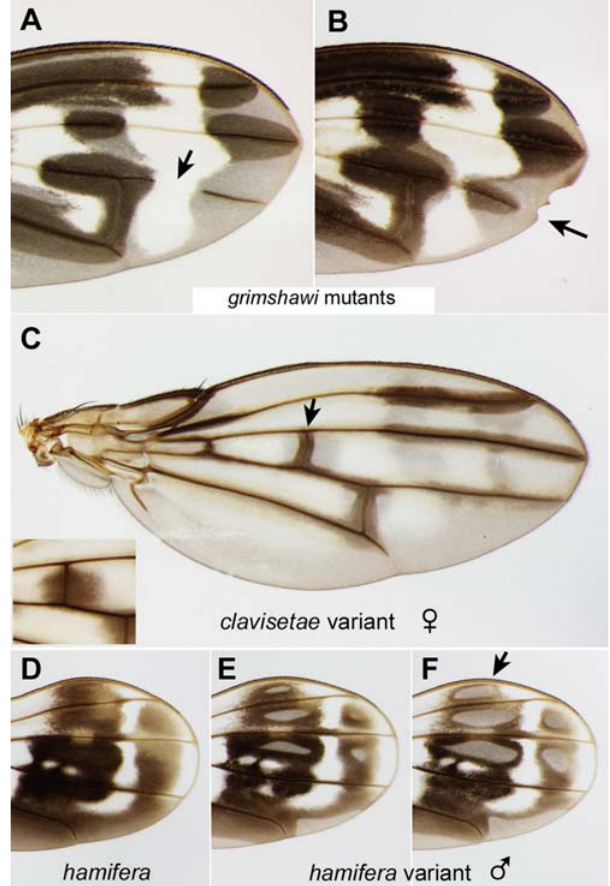
Figure 9. Variants that uncouple the prepattern from the vein- dependent pattern. A–B. Wings from grimshawi mutant lines. A . weak veins mutant with a gap in L4 (arrow); dark pigment is absent from the distal L4 vein fragment. B . Wing notching in a Nihoa mutant is associated with a shortened L4 and a reduced distal spot (arrow). In both A and B , the prepattern of dark hairs is not affected [21]. C . Rare, natural variant of clavisetae with incomplete pigmentation; this defect is seen in both wings. Compare the central crossvein in the variant (arrow) to that of a typical clavisetae female (inset). D–E. Wings from two hamifera males. D . Normal pattern. (This wing and the one in Fig. 2 are a pair from one male). E, F. Pair of wings from a different male. As in C , the intervein regions have not fully pigmented; see for example the spot indicated by the arrow.